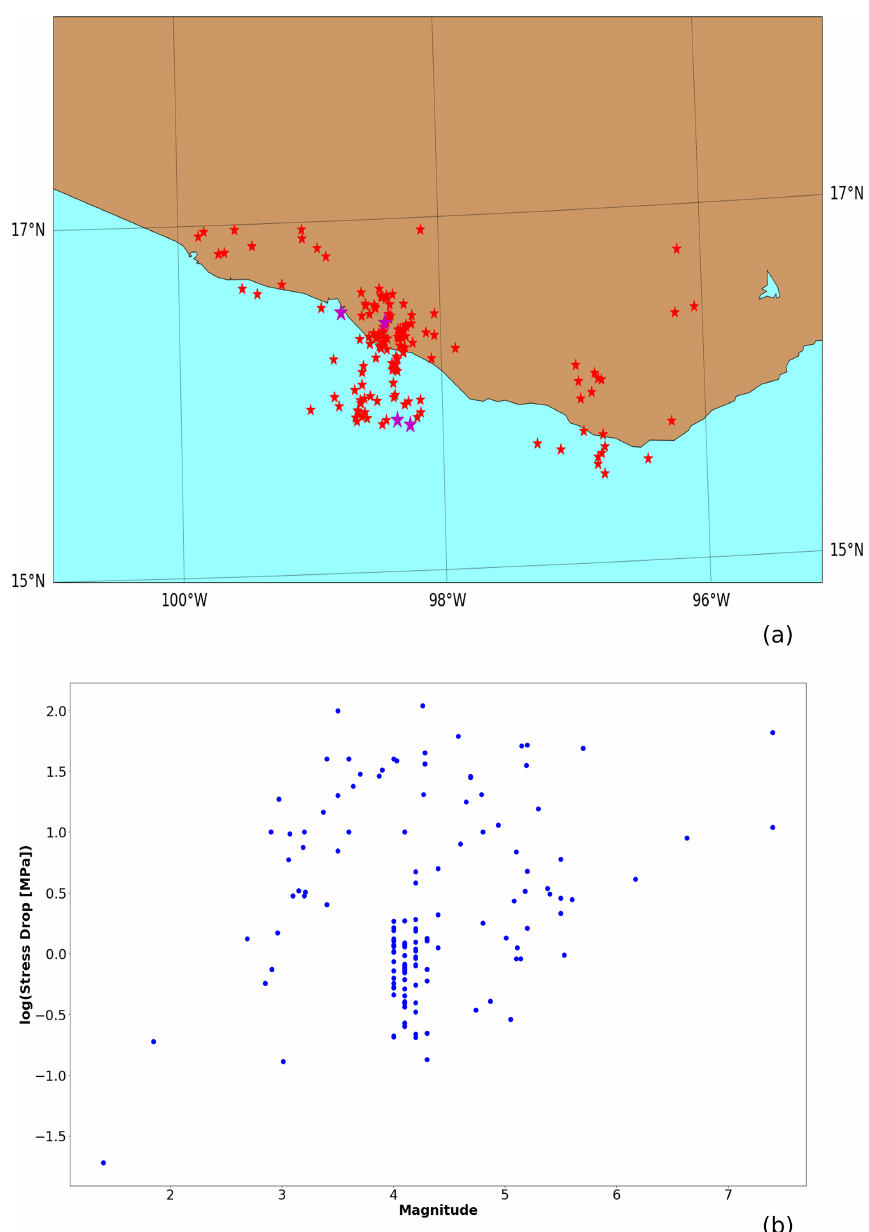
Figure 3. (a) Spatial distribution of earthquakes with computed stress drop in Rodríguez-Pérez et al. (2018) and the four analyzed earthquakes in red and magenta stars, respectively. (b) Stress drop vs. magnitude distribution of red stars